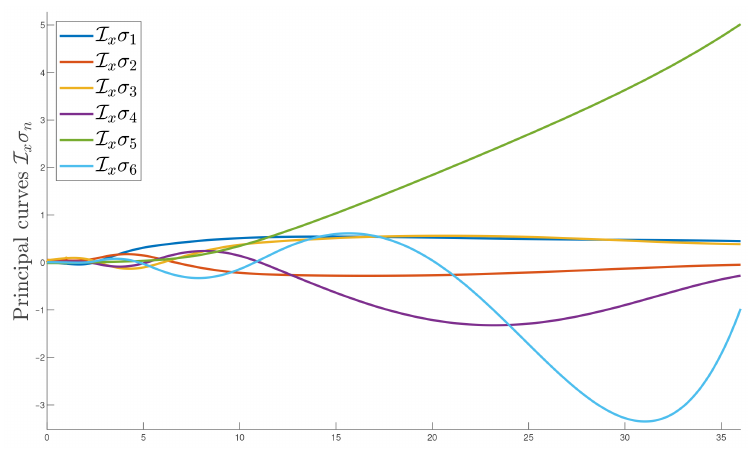
Figure 3. Six principal modes responsible for over 99% of variation. Table 2. Least-squares estimates for the first p (cid:48) = 6 parameteres λ k . ˆ λ 1 ˆ λ